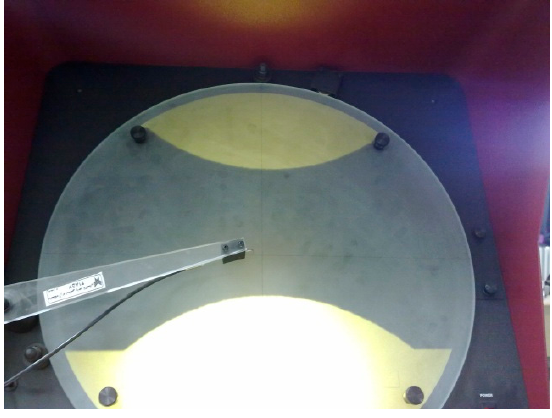
Figure 5. Projected picture of the specimen on the projector screen.